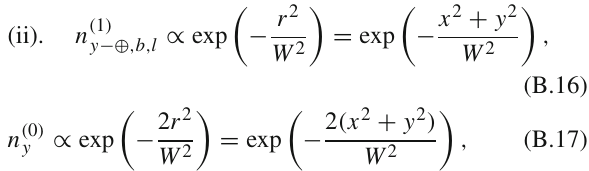
(I) y −⊕ , b , l ( 0 ) ( 1 ) propa- y (II). It is shown that n y −⊕ , b , l ( 0 ) y propagates always in